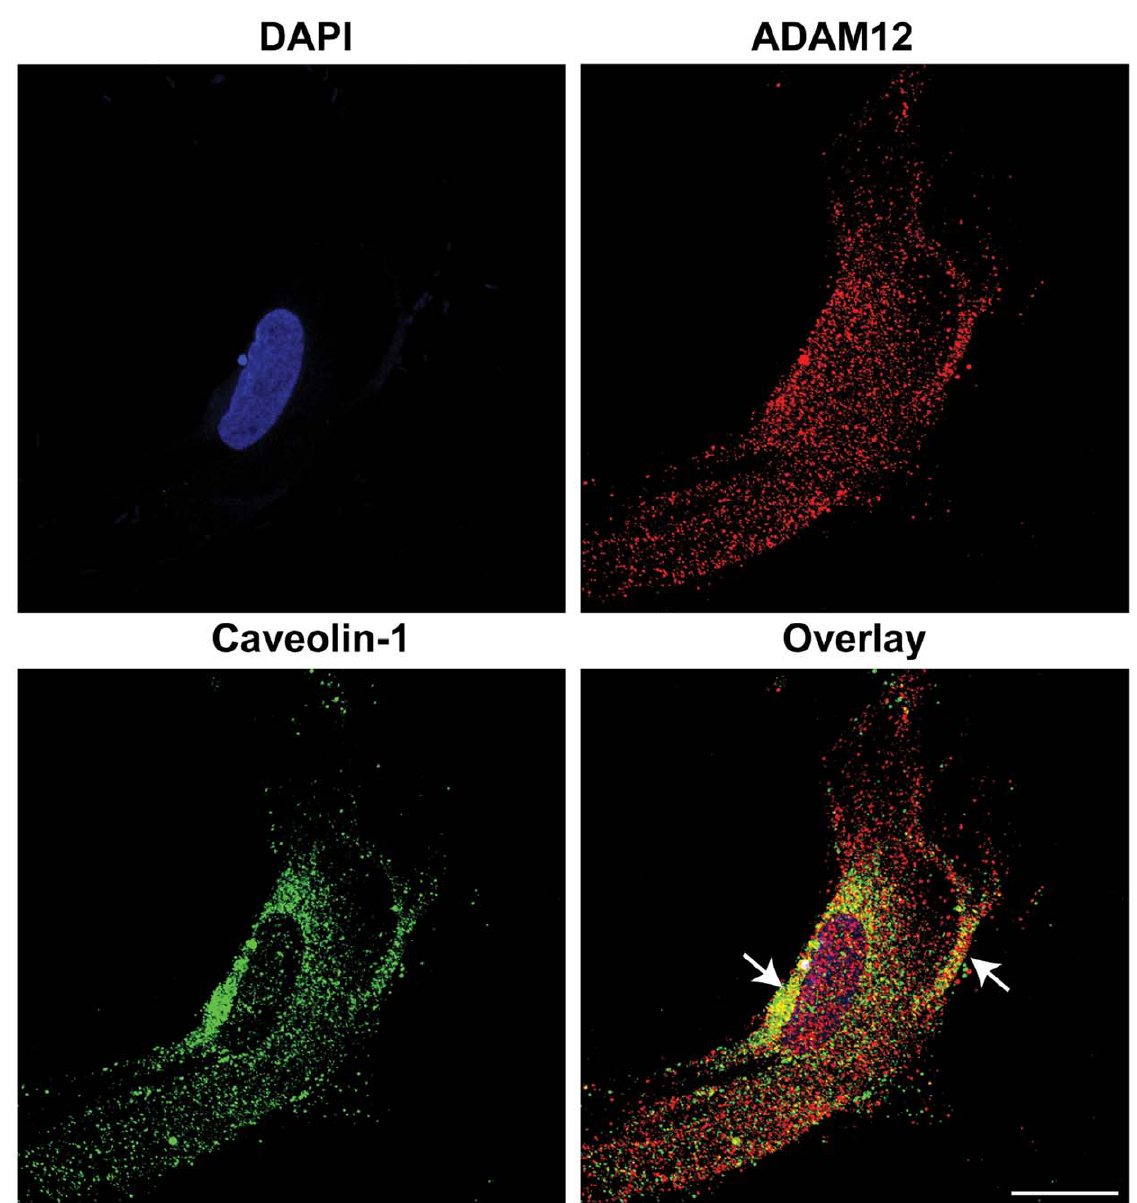
Figure 4. Co-localization of ADAM12 and caveolin-1 in hASCs. hASCs that overexpressed ADAM12 were immunostained with anti-ADAM12 and anti-caveolin-1 antibodies (Bar=20 m m). Images for ADAM12 (red color) and caveolin-1 (green color) were overlaid, and arrows indicate colocalization of ADAM12 and cavelin-1. Representative data from three independent experiments are shown.